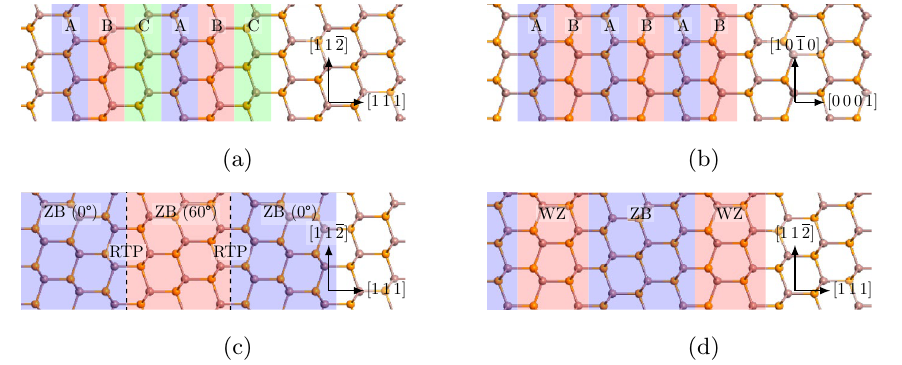
Figure 1. The 4 different kinds of InP systems investigated in this paper. ( a ) Pristine Zincblende (ZB). ( b ) Pristine Wurtzite (WZ). ( c ) A Rotational Twin Plane (RTP), here shown with a periodicity of 1 RTP every 3 layers of ZB. ( d ) A mixture of WZ and ZB, here shown with a periodicity of 2 layers WZ every 3 layers